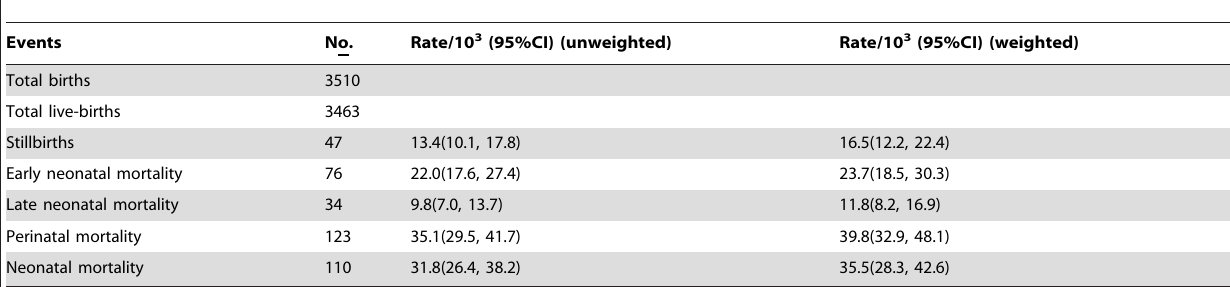
Table 3. The status of neonatal mortality in Jimma Zone, Southwest Ethiopia, September 2012-December 2013 (n